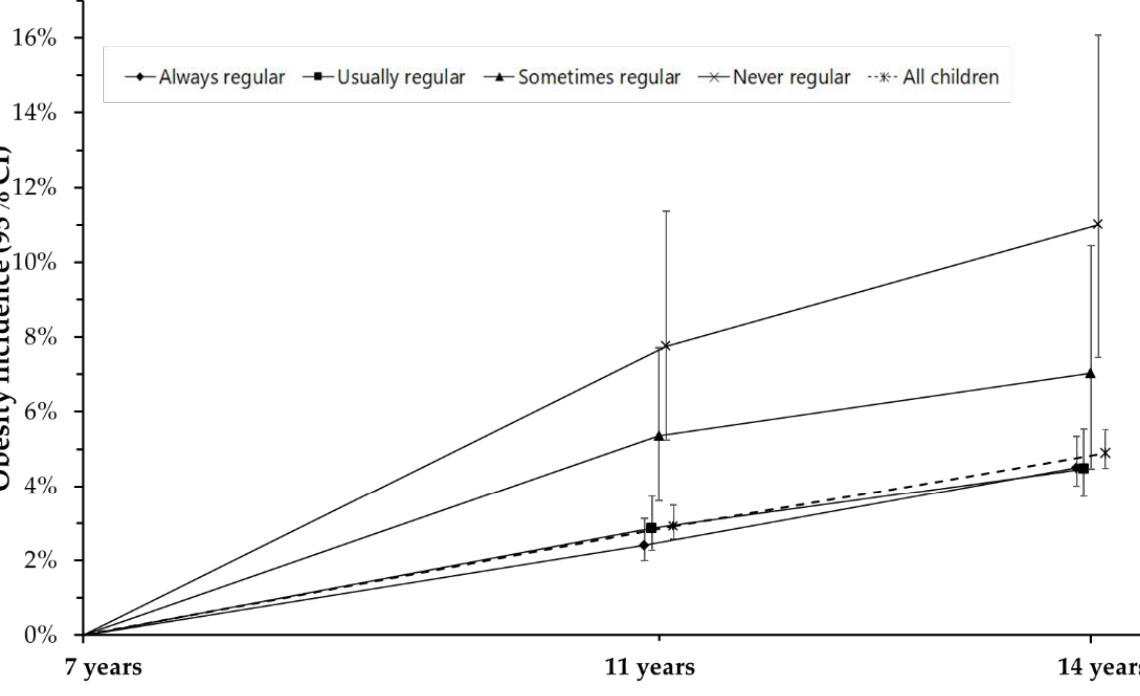
Figure 4. Trajectory of obesity incidence at 11 and 14 years by bedtime regularity among non-obese 7-year-olds. Error bars represent 95% CI of the estimates. Table 1. Weighted mean body fat percentage (95% CI) at 11 and 14 years by term-time bedtimes and bedtime schedules of non-obese children at 7 years.